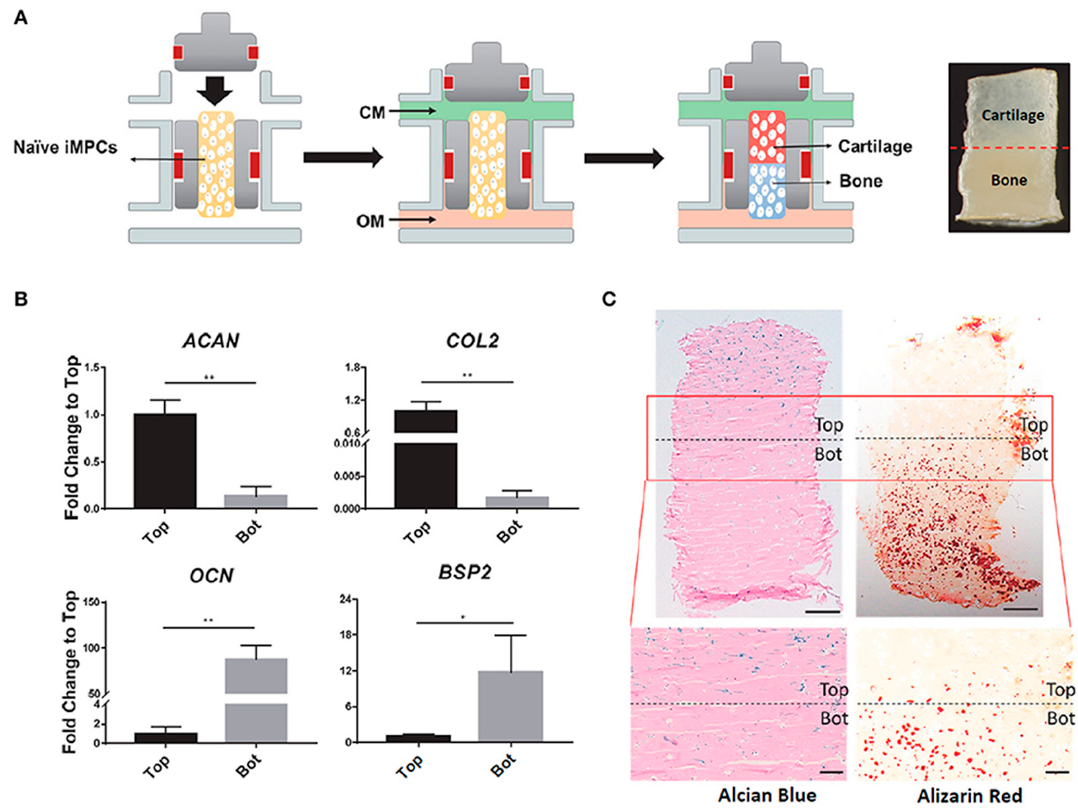
Figure 6. Potential of dual-flow perfusion bioreactors for the development of hiPSC-derived OC tissue. ( A ) Schematic representation of the OC tissue construct containing cartilaginous and osseous layers, as well as of the dual-flow bioreactor system where the constructs were placed and perfused with optimised chondrogenic (CM) and osteogenic (OM) media through the top and bottom flow, respectively, to promote the formation of the biphasic tissue. ( B ) Characterisation of the engineered OC construct in terms of the expression levels of chondrogenic (aggrecan—ACAN, collagen type 2—COL2) and osteogenic (osteocalcin—OCN, bone sialoprotein 2—BSP2) markers, in the top (Top) and bottom (Bot) sections of the construct, 28-days after differentiation; * p < 0.05; ** p < 0.01. ( C ) Histological examination of the biphasic OC tissues as regards the deposition of the tissue-specific matrix; Alcian Blue positive staining is restricted to the top of the construct (cartilage), whereas Alizarin red positive staining is limited to the bottom part (bone). Scale bar = 500 µ m ( top panel ); Scale bar = 200 µ m ( bottom panel ). Adapted from [261] with permission from Frontiers. Copyright © 2007–2021 Frontiers Media